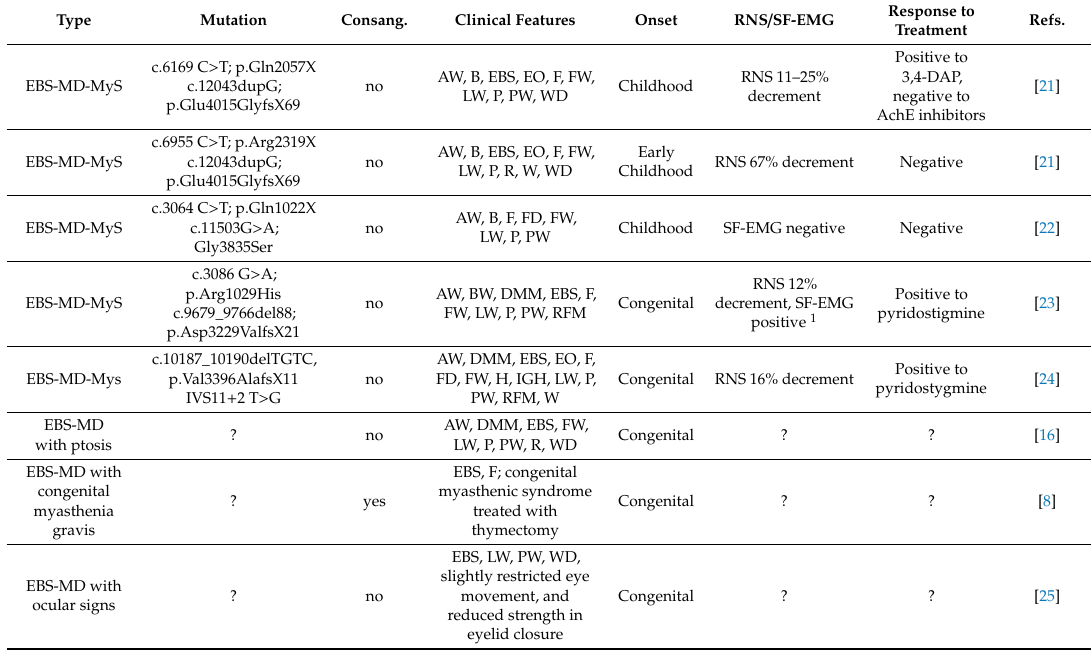
Table 2. Review summary of cases with EBS-MD-MyS or EBS-MD with myasthenic features.